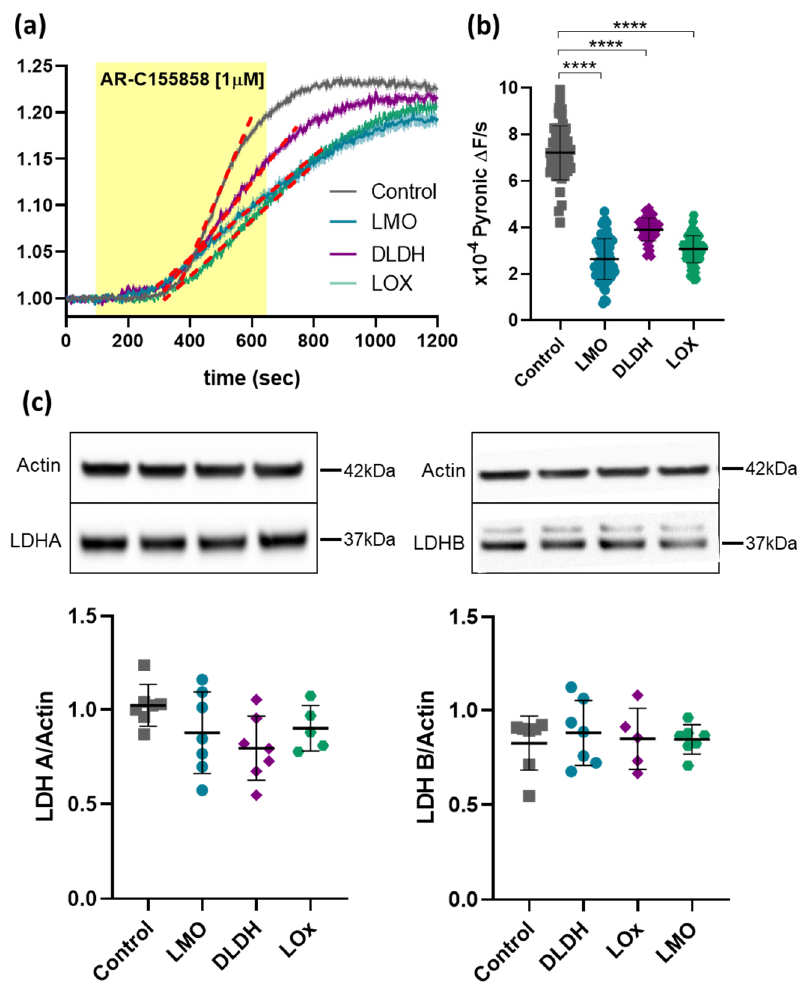
Figure 7. Intracellular pyruvate build-up upon blockade of MCT1. ( a ) Time course of the average Pyronic FRET ratio upon AR-C155858 [1 µM] application in primary cultured astrocytes transduced with AVV-CMV-Pyronic alone (Control, n = 52) or in combination with either AVV-sGFAP-LMO-IRES-tdTomato (LMO, n = 69), AVV-sGFAP-DLDH-IRES-tdTomato (DLDH, n = 53), or AVV-sGFAP-LOx-IRES-tdTomato (LOx, n = 72). The dotted red lines on the representive slopes and the shaded regions around the trace are SEM. ( b ) Pooled data for the slope of pyruvate production; **** p < 0.0001, one way ANOVA with Tukey multiple comparison test. ( c ) Western blot analysis of LDHA and LDHB levels in primary cultured astrocytes expressing LMO, DLDH, and LOx; upper—representative blots; lower—quantification of the ratios of LDHA or LDHB to actin ( n = 7 for all groups).